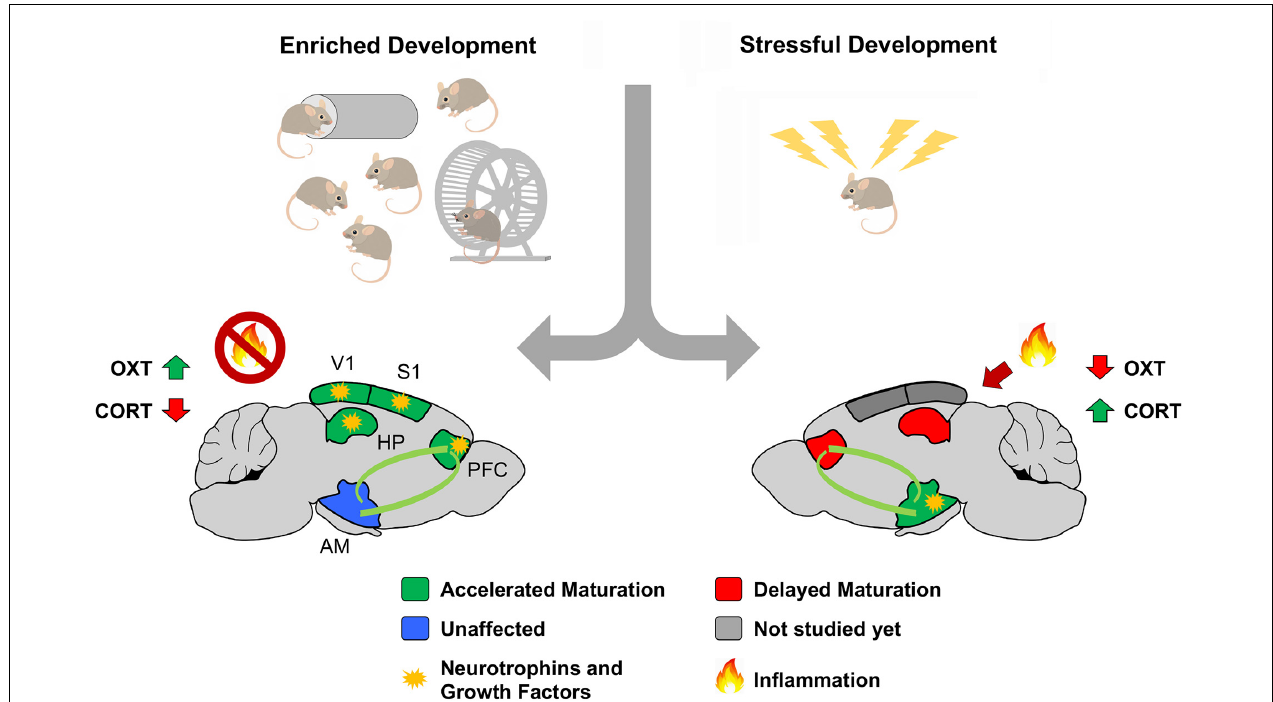
FIGURE 2 | Theoretical model summarizing the impact of early life experiences on postnatal brain development. We propose a model where early-life experience biases the allocation of systemic factors (putatively neurotrophins and growth factors) based on adaptive needs. Hypertrophy of regions contributing to emotional regulation might result in maladaptive states of hypervigilance, stress and anxiety, laying the foundation for a variety of psychiatric conditions. Abbreviations: AM, Amygdala; CORT, corticosterone; HPP, hippocampus; OXT, oxytocin; PFC, prefrontal cortex; S1, primary somatosensory cortex; V1, primary visual cortex. Adapted from